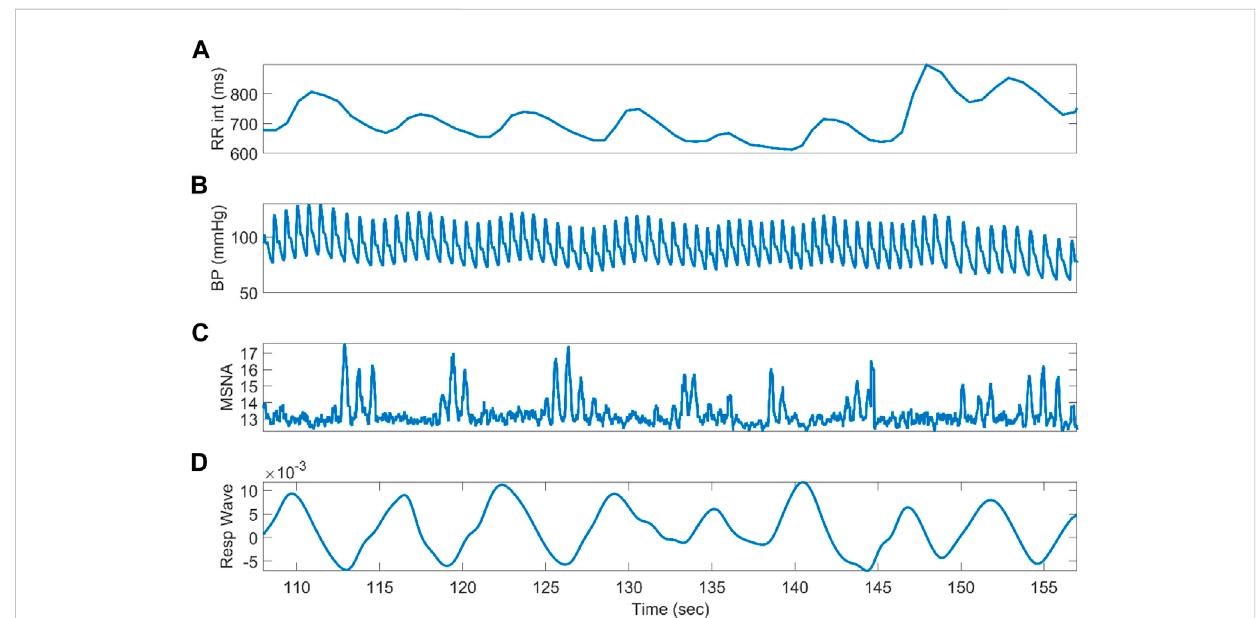
FIGURE 2 Physiological recordings from a representative normotensive pregnant woman at rest. From the top, it can be seen RR interval (A) , blood pressure wave (B) , integrated muscle sympathetic nerve activity (C) , and respiratory wave (D) .